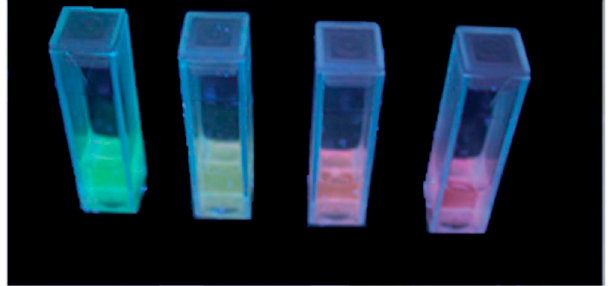
Figure 15. Picture of Eu 3+ - and Tb 3+ -doped CaF 2 excited with 366 nm (from left to right: CaF 2 :Tb10, mixture of 52% of CaF 2 :Tb10, and 48% of CaF 2 :Eu10, CaF 2 :Eu4.8,Tb5.2, and CaF 2 :Eu10). Reproduced from Reference [57] with the permission of the Royal Chemical Society.